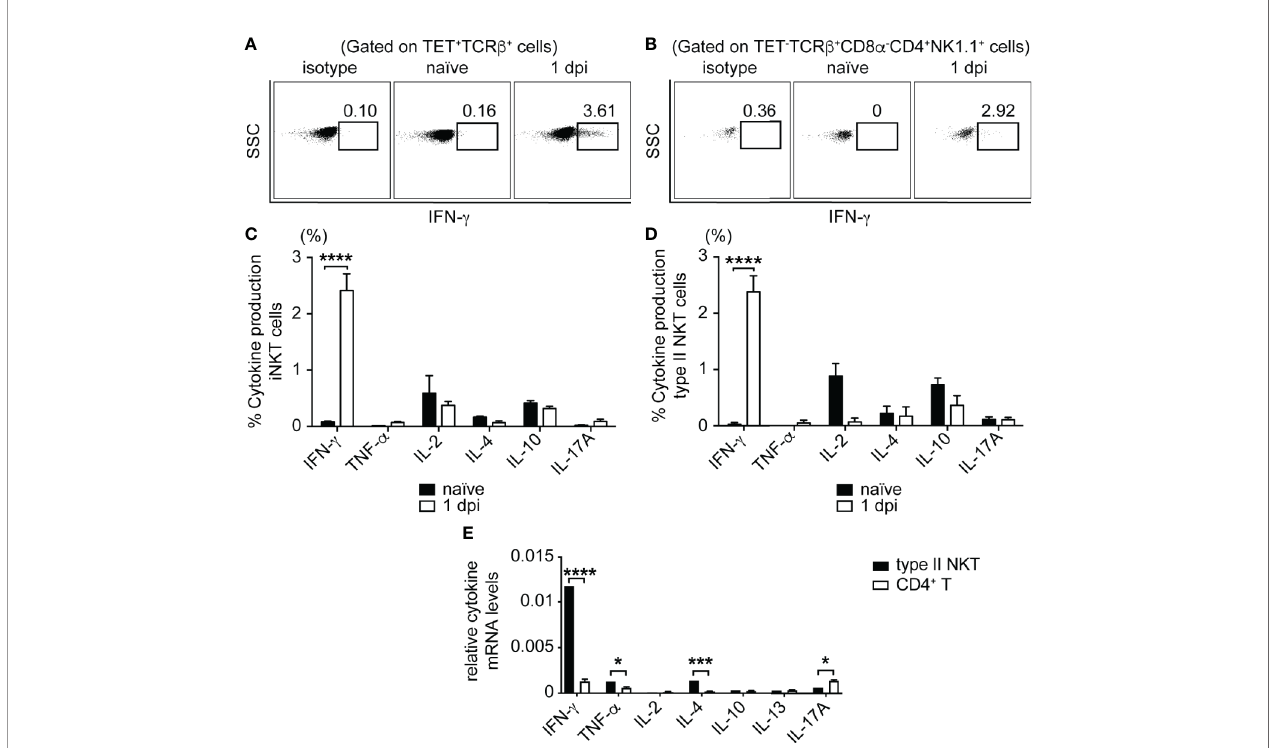
FIGURE 4 | iNKT and type II NKT cells produce IFN- g after SA infection. (A, B) Representative FACS plots of IFN- g production of iNKT (A) and type II NKT (B) cells at 1 dpi from B6 liver, cultured directly ex vivo . (C, D) Quanti fi ed % cytokine production, gated on iNKT cells (C) and type II NKT cells (D) . (N=3 – 6 naïve, N=5 – 12 infected mice). (E) rtPCR of cytokine mRNA of type II NKT cells sorted from 4 dpi J a 18 -/- mouse pooled liver lymphocytes (N=10 mice) compared to sorted conventional CD4 + NK1.1 - T cells from J a 18 -/- splenocytes (N=2 mice), data represented as cytokine mRNA levels relative to b -actin. Statistical analysis: (C – E) 2-way ANOVA. *p < 0.05; ***p < 0.001; ****p <